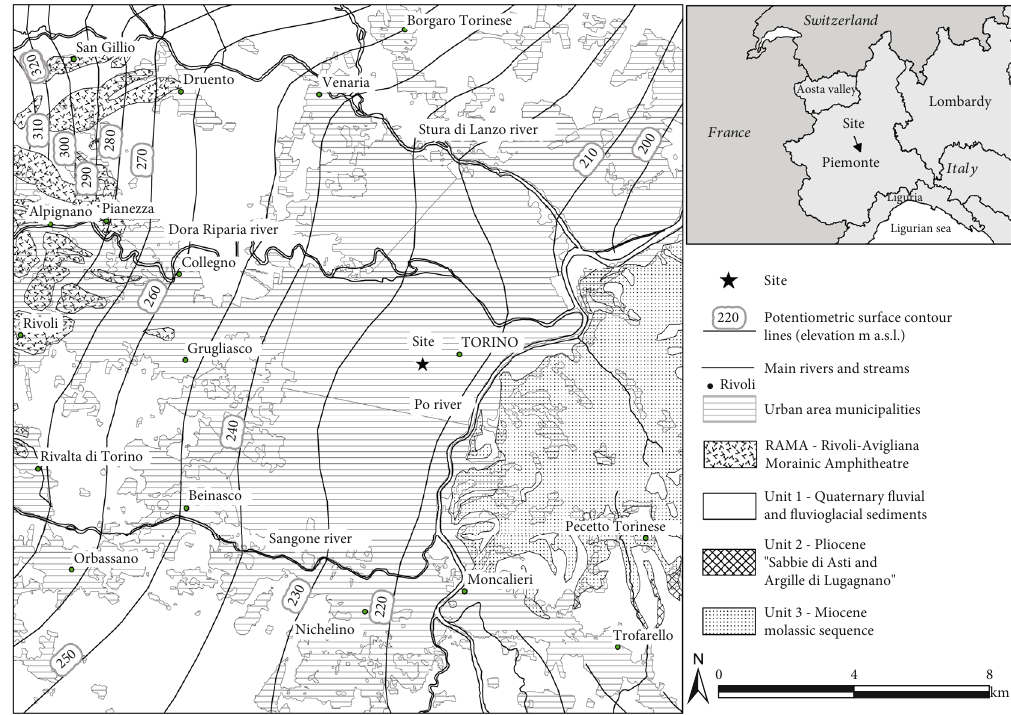
Figure 2: Hydrogeological map of the Turin area and test site location (modi fi ed from